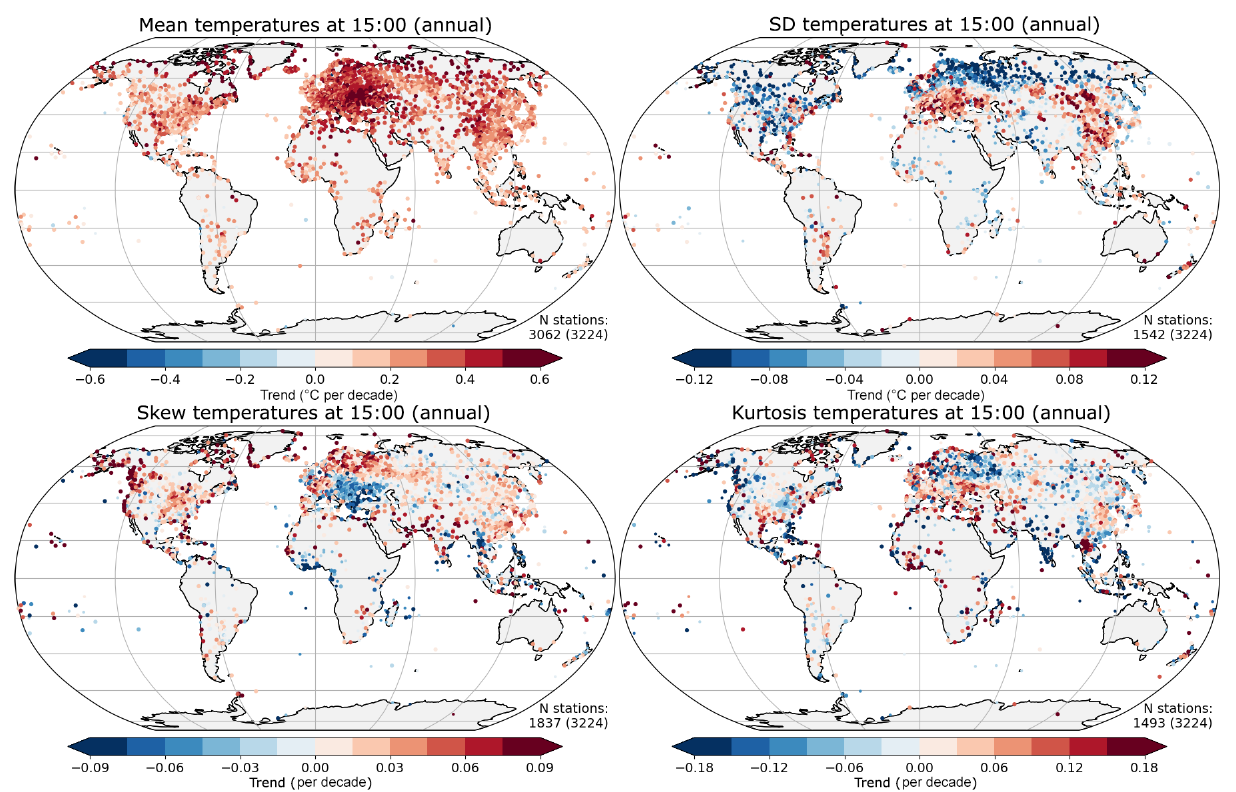
Figure 3. Trend over 1974–2018 in distribution parameters for temperature at 15:00LT, showing the mean, standard deviation, skew and kurtosis. The stations where the 1 ˆ σ range of the fitted trend excludes zero are plotted with a larger symbol (the number of these is shown in the bottom right-hand corner of each plot). The total number of stations available is shown in